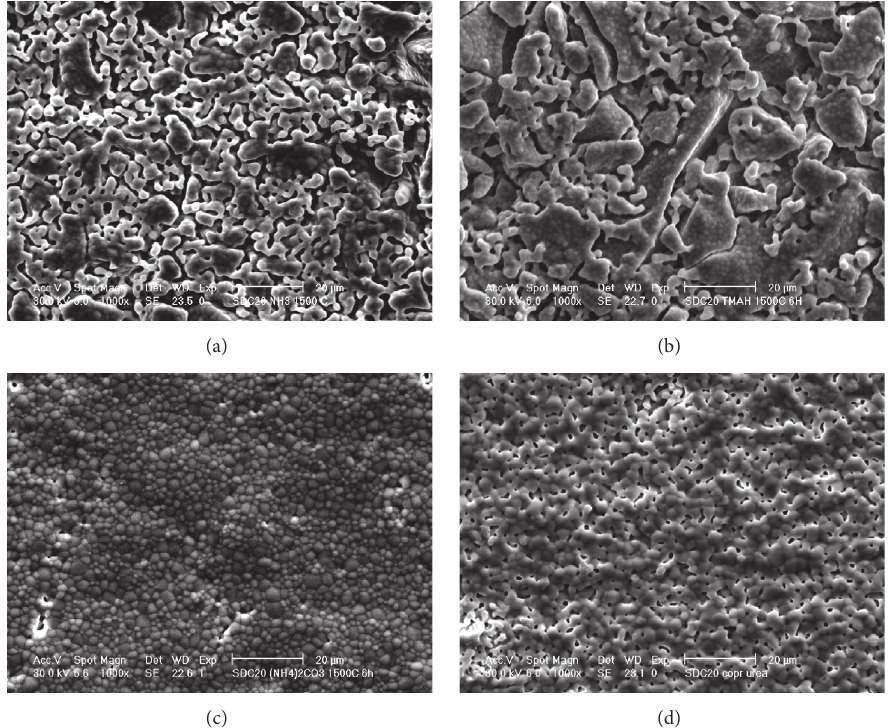
Figure 5: SEM micrographs of sintered pellets at low magnification (1000x): N-SDC20 (a), T-SDC20 (b), C-SDC20 (c), and U-SDC20